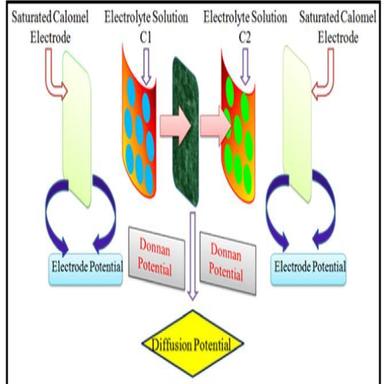
Electrochemical setup for ionic potential measurement.